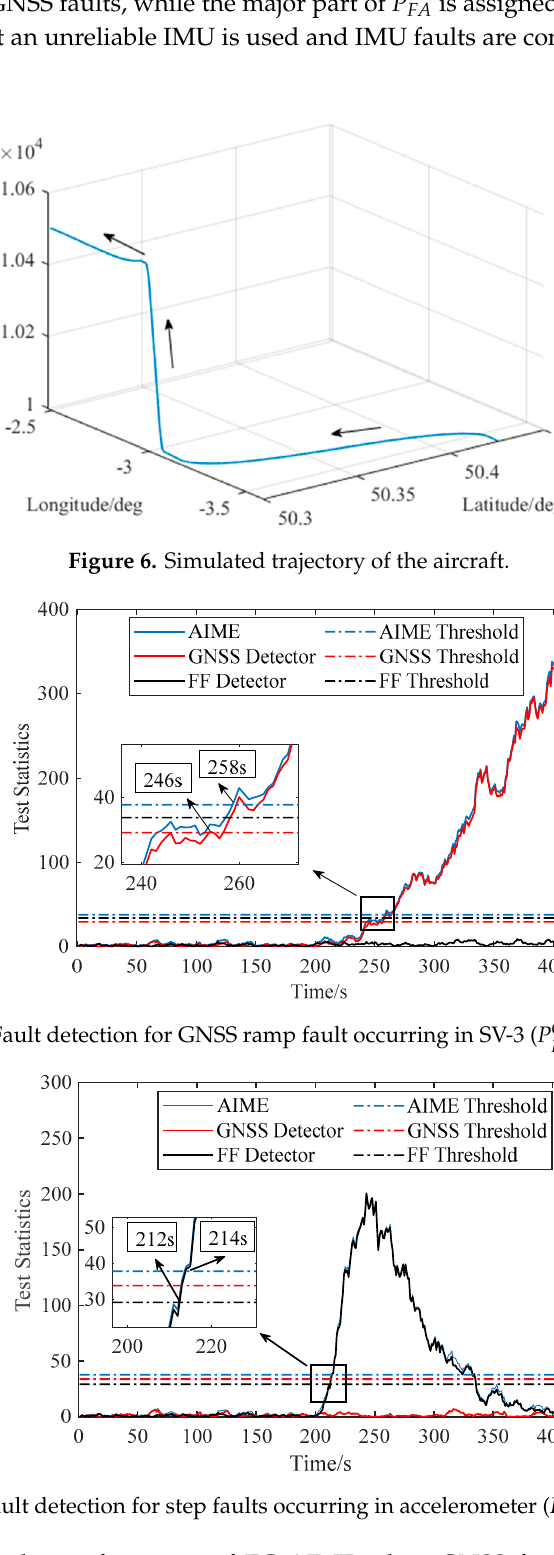
Table 5. Fault scenarios in the simulations.